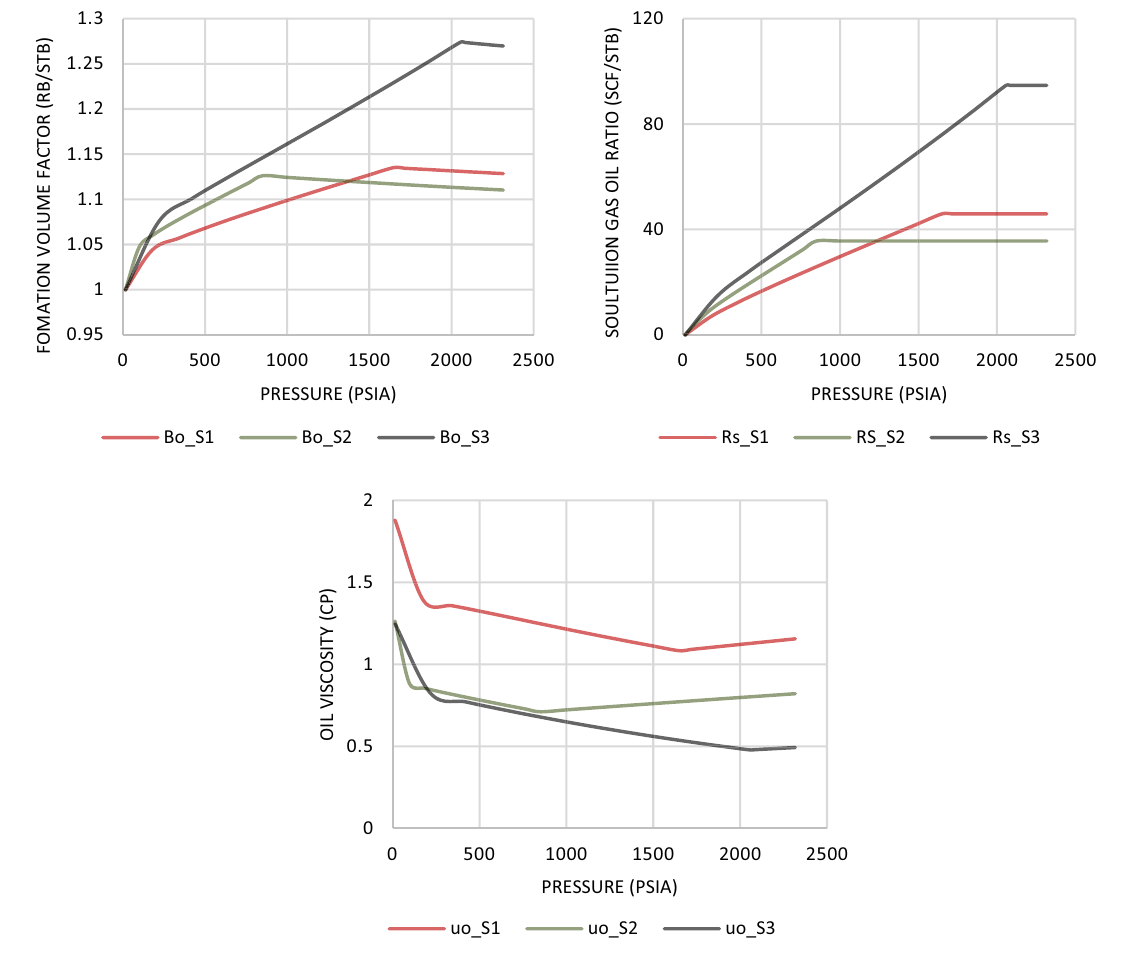
Fig. 4 Calculated formation volume factor, solution gas–oil ratio and oil viscosity of S1, S2 and